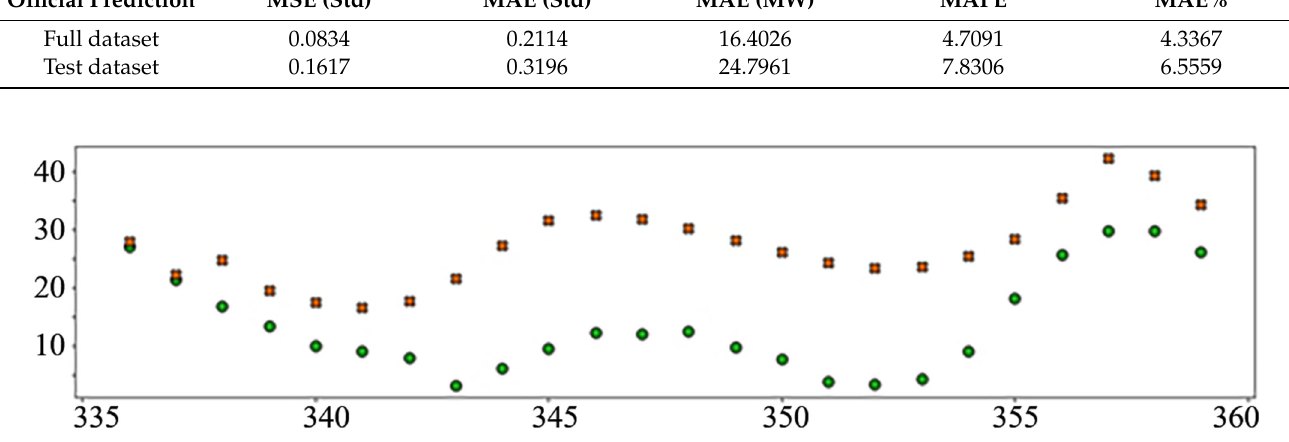
Figure 18. An example of a wrong AR LSTM prediction.